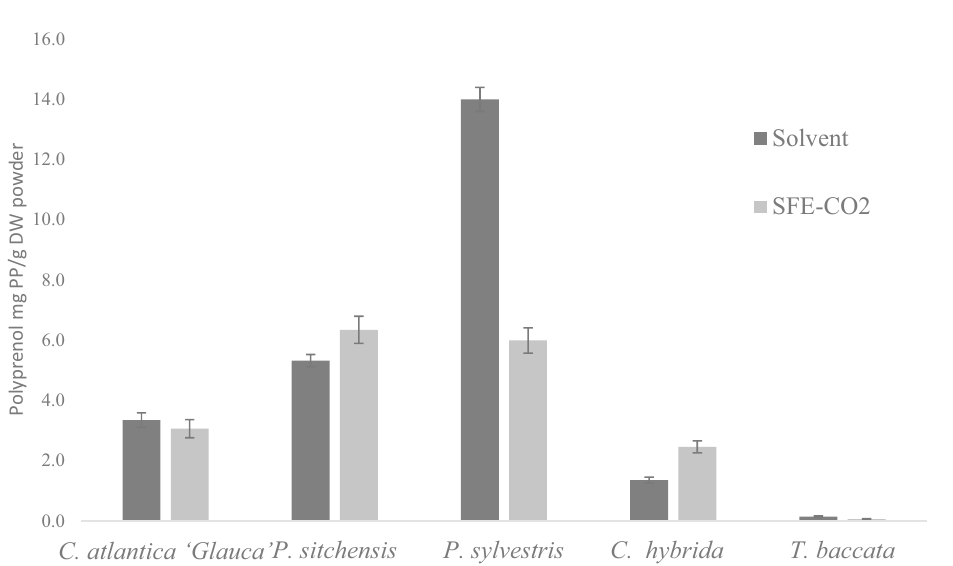
Figure 4. The total polyprenol content extracted by both extraction method (mg/g DW) calculated for C. atlantica ‘Glauca’, P. sitchensis, P. sylvestris, C. hybrida and T. baccata Each value presents the mean value ± SD. Figure prepared using Microsoft excel (Version 16.39, Microsoft 365 subscription, data analysis 2019